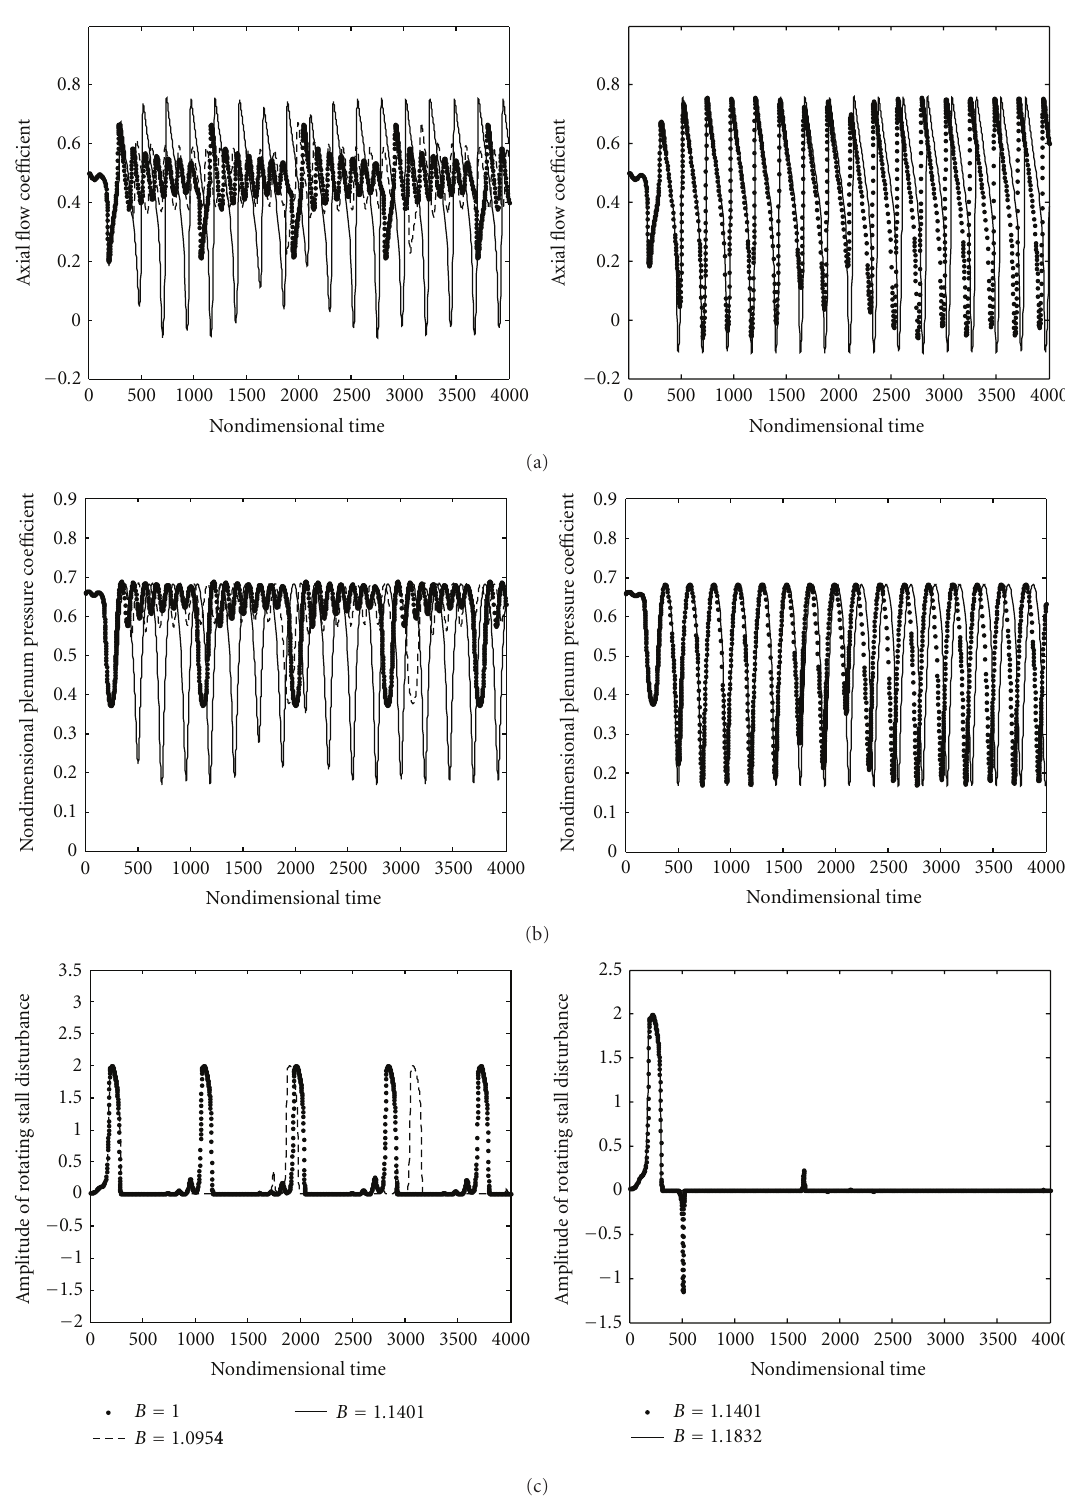
Figure 6: Temporal variation of nondimensional flow properties (a), (b), and (c) with increase in size of plenum: (a) axial flow coe ffi cient, (b) plenum pressure rise coe ffi cient, and (c) disturbance amplitude of rotating